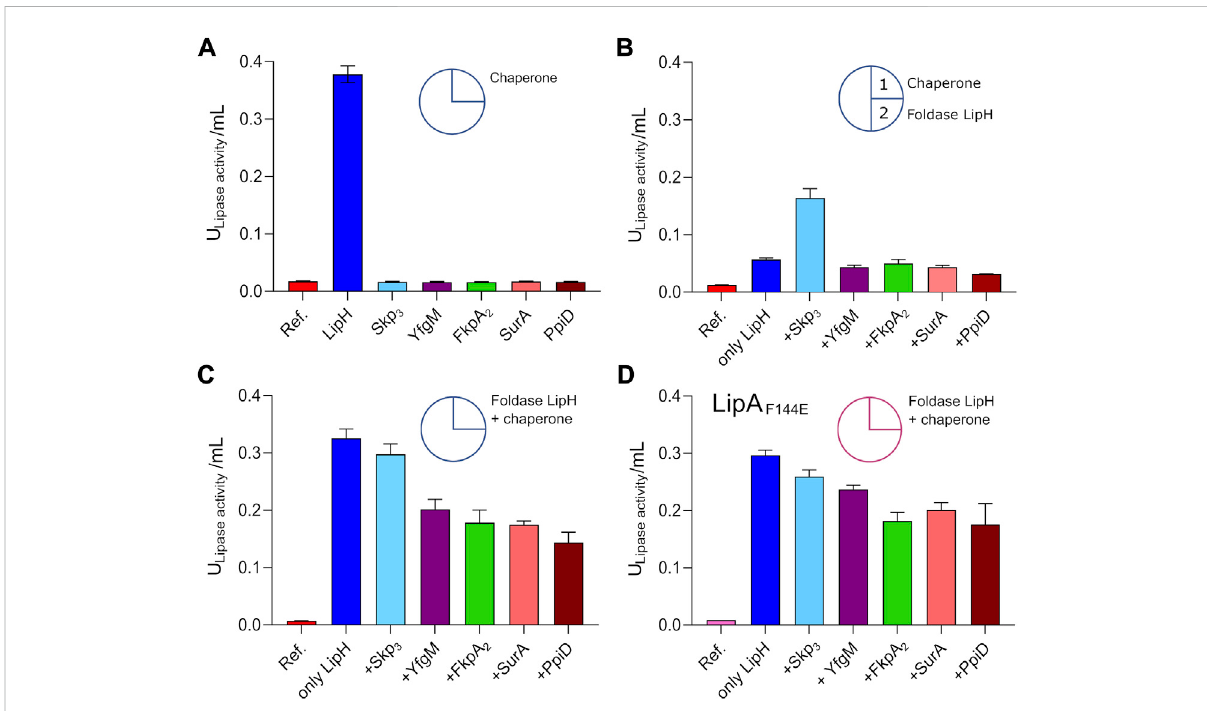
FIGURE 5 Interplay of periplasmicchaperones uponthelipase activation. The lipaseactivityagainst p NPB overthe fi rst 15 min ofthehydrolysis reaction is shown in bars. Circle scheme describes the incubation steps. LipA activity in absence of chaperones is indicated as “ Ref. ” . (A) Incubation of the wild- type LipA with either the foldase LipH or general periplasmic chaperones in the TGCG buffer. (B) Initial incubation of the wild-type LipA with general periplasmic chaperones at 100 mM NaCl (1) followed by incubation with LipH (2). (C) Simultaneous incubation of the wild-type LipA with LipH and periplasmic chaperones in 50 mM NaCl, 1 mM CaCl 2 , 10% glycerol (v/v) and 20 mM Tris-HCl pH 8.0. (D) Simultaneous incubation of the